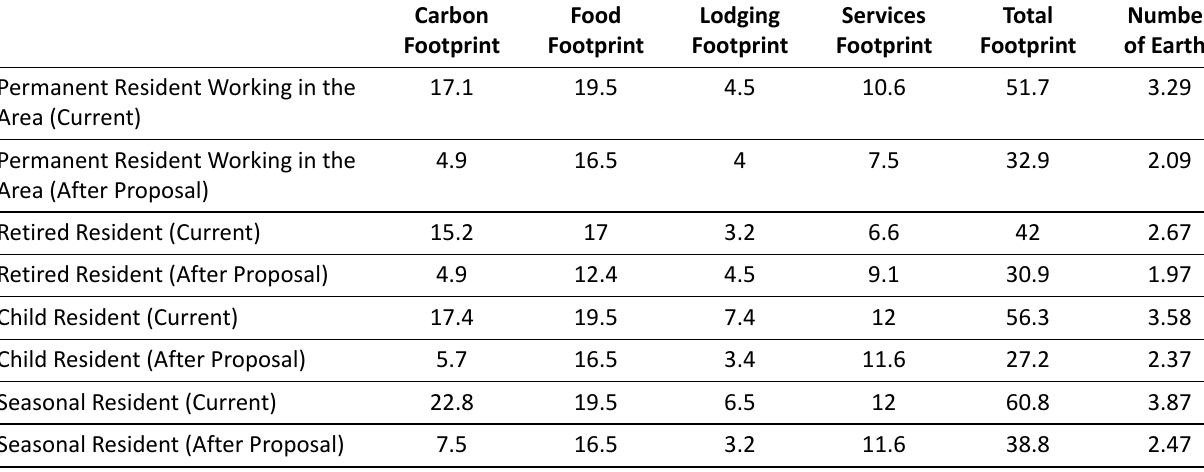
Table 3. Current and expected EF (global hectares) for different inhabitants profiles in the Pedralbilla-Torre de Portaceli housing estate. Source: Galan